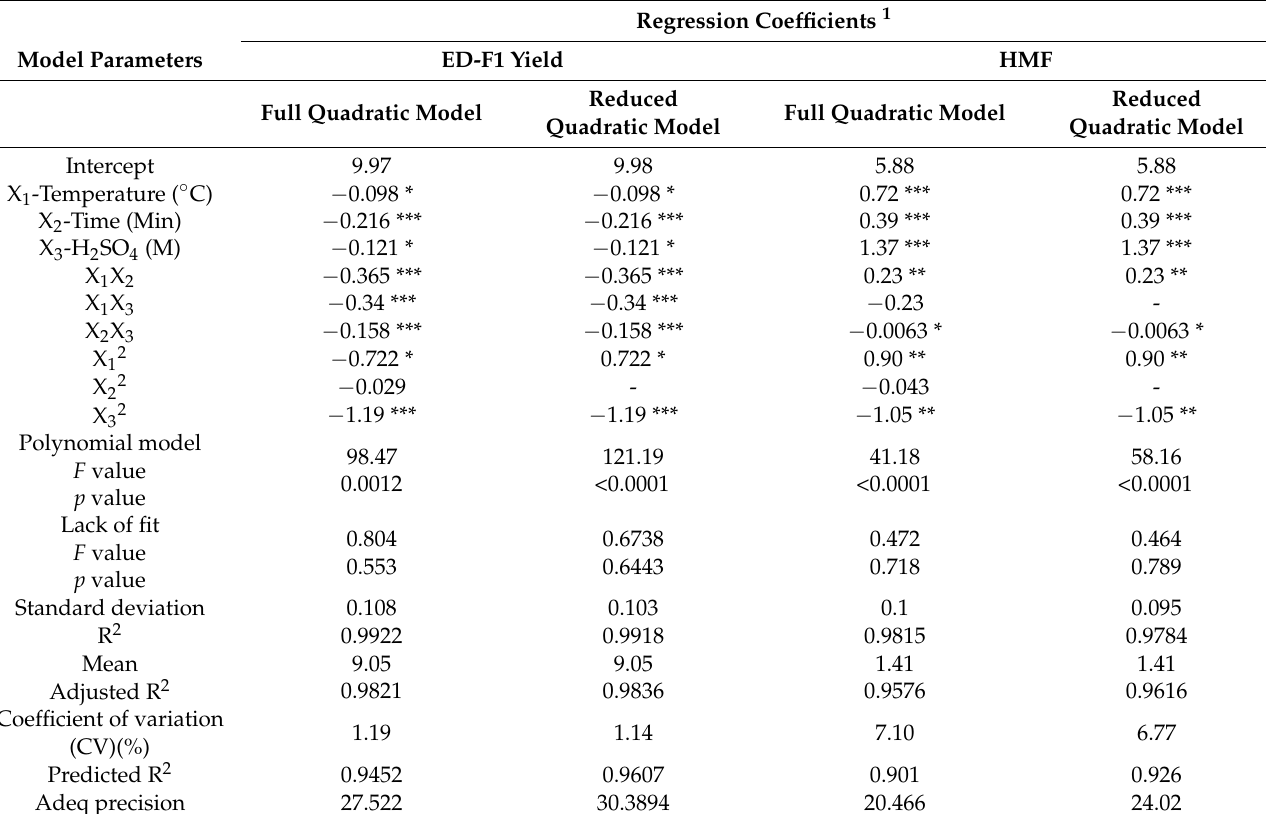
Table 2. Regression coefficients for the polynomial model for oligosaccharides hydrolysis from E. denticulatum